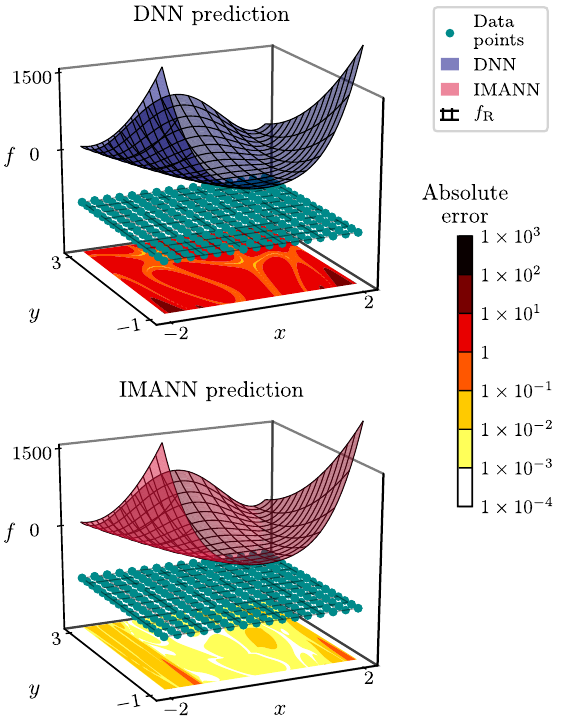
Figure 13. Rosenbrock function prediction with DNN and IMANN for 256 data points. Surfaces correspond to predicted value, wireframe to original function, blue points indicate data points and colormap on the bottom indicates absolute